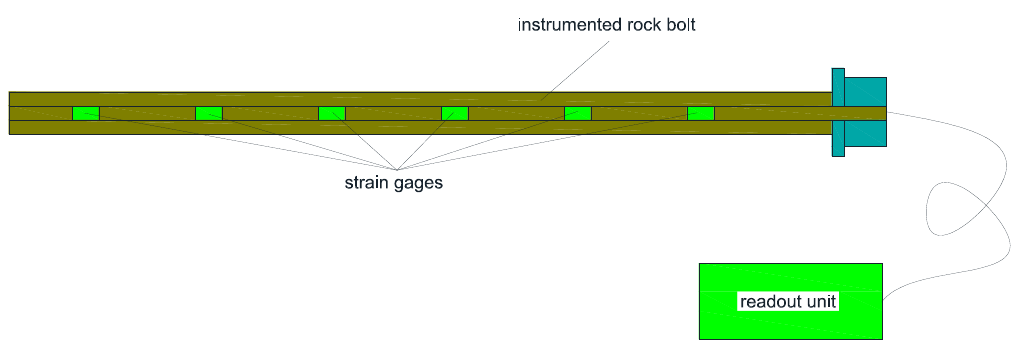
Figure 4. The illustration of an instrumented rock bolt.